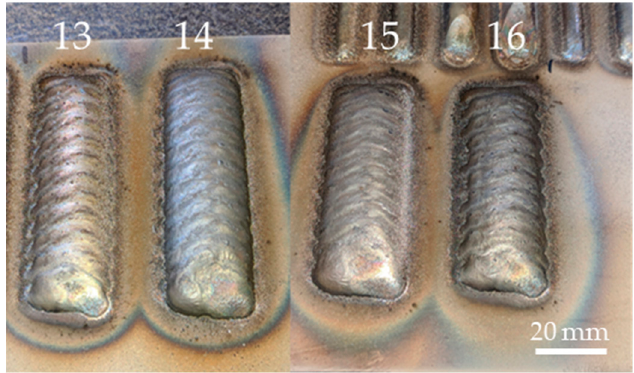
Figure 5. Oscillation bead on plate welding test. Table 2. Test processing parameters.